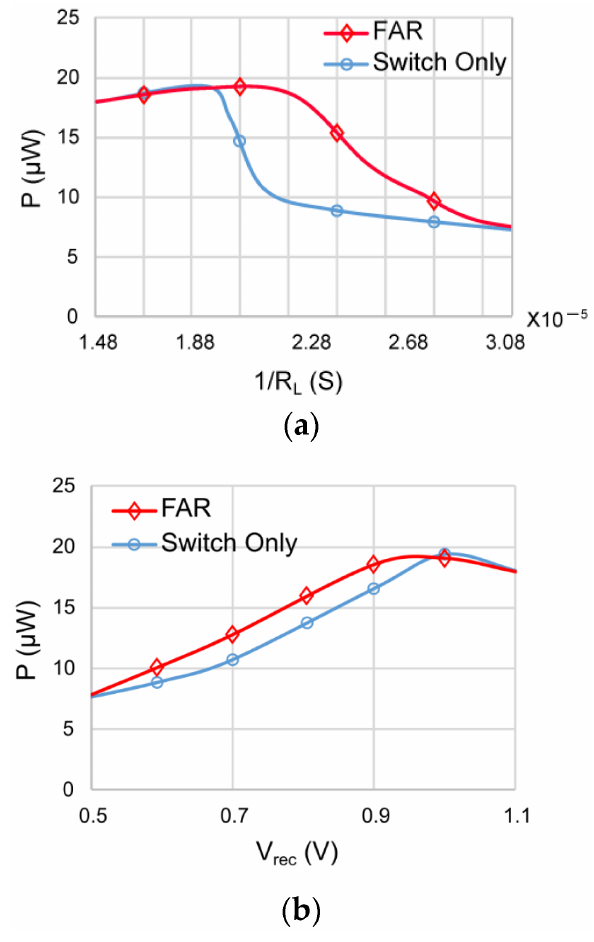
Figure 14. Output power as a function of ( a ) 1/ R L , ( b ) V rec